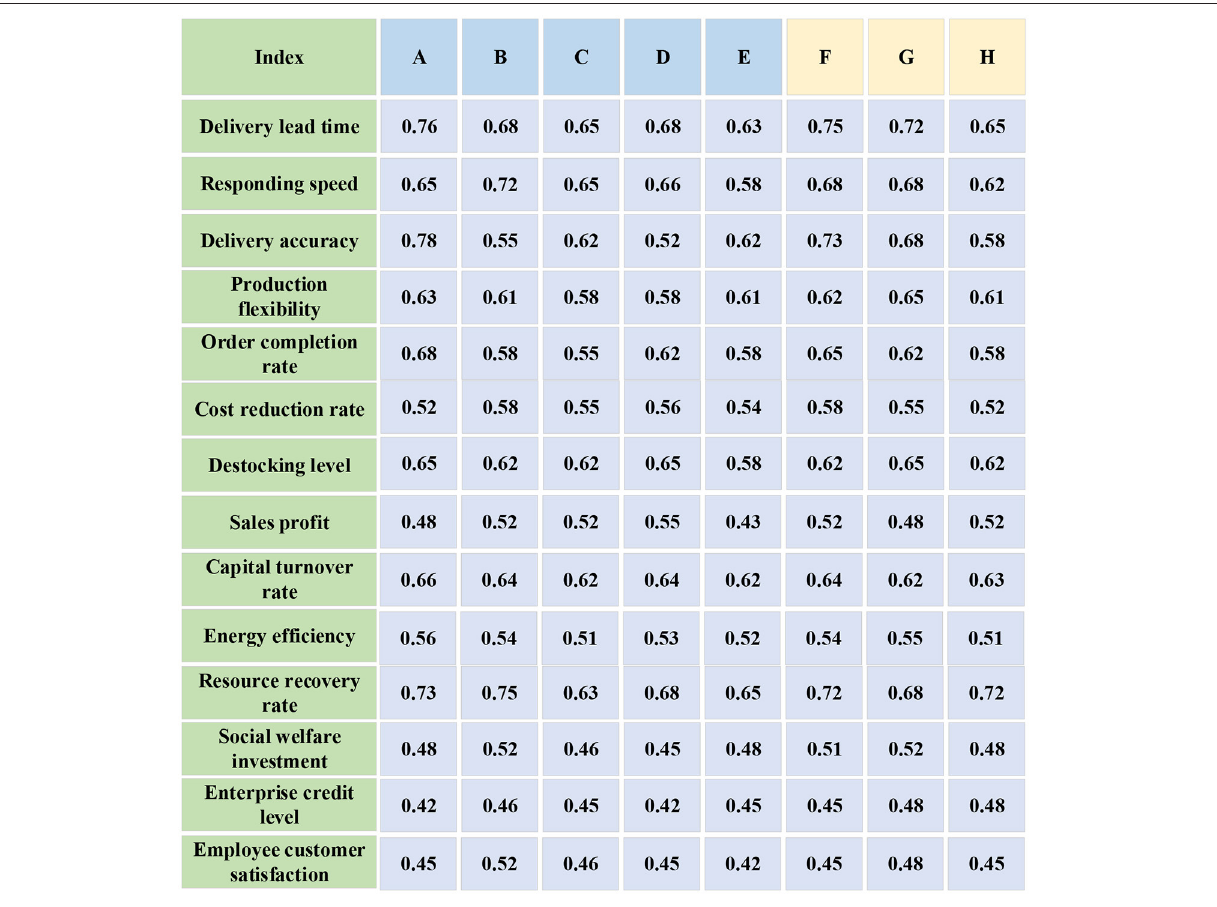
FIGURE 6 | The data of testing and training sample.